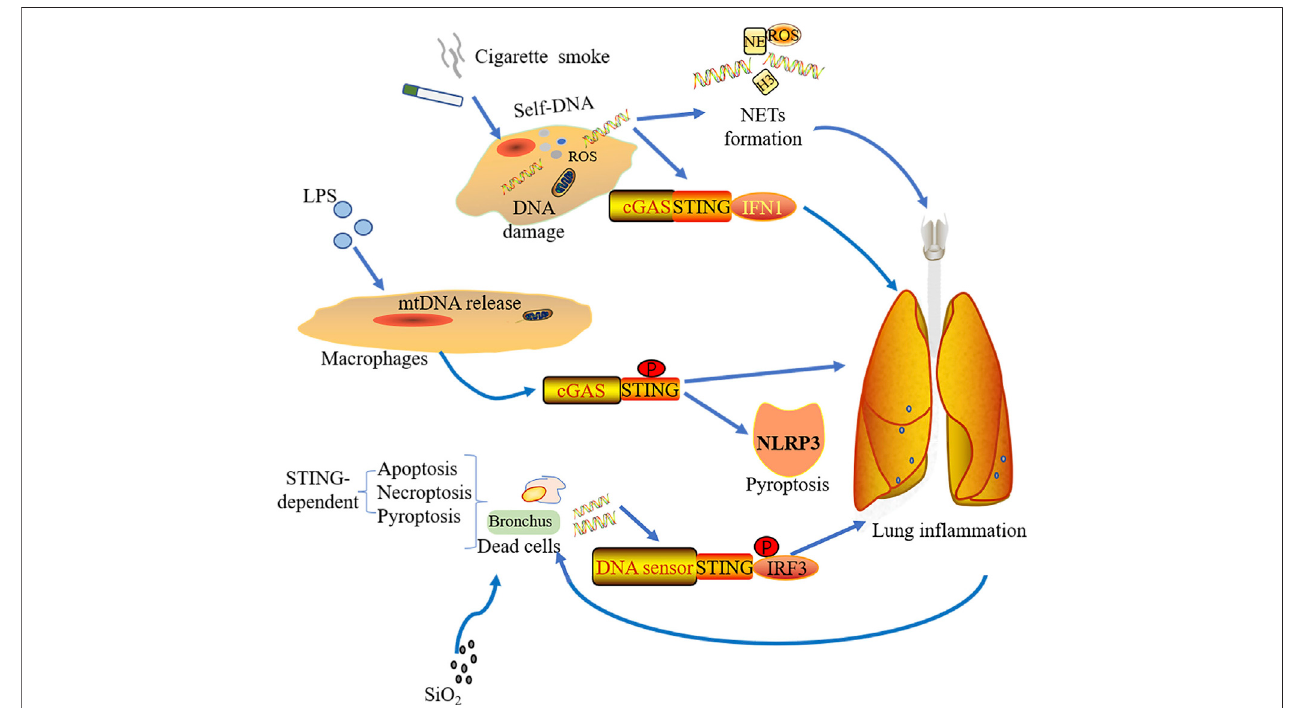
FIGURE3| Stimulationsfromvarioussourcesinducepulmonaryin fl ammationthroughthecGAS-STINGpathway.Cigarettesmokemediateslungin fl ammationby the activation of cGAS-STING-IFN1 and the formation of NETs. With simulations of LPS, macrophage could release mtDNA, which was sensed by cGAS-STING and induced NLRP3-mediated pyroptosis as well as lung in fl ammation. Silica exposure to bronchus leads to different forms of STING-dependent cell death including apoptosis, necroptosis, and pyroptosis. The dsDNA from the dead cells triggers lung in fl ammation via STING-IRF3 signaling.